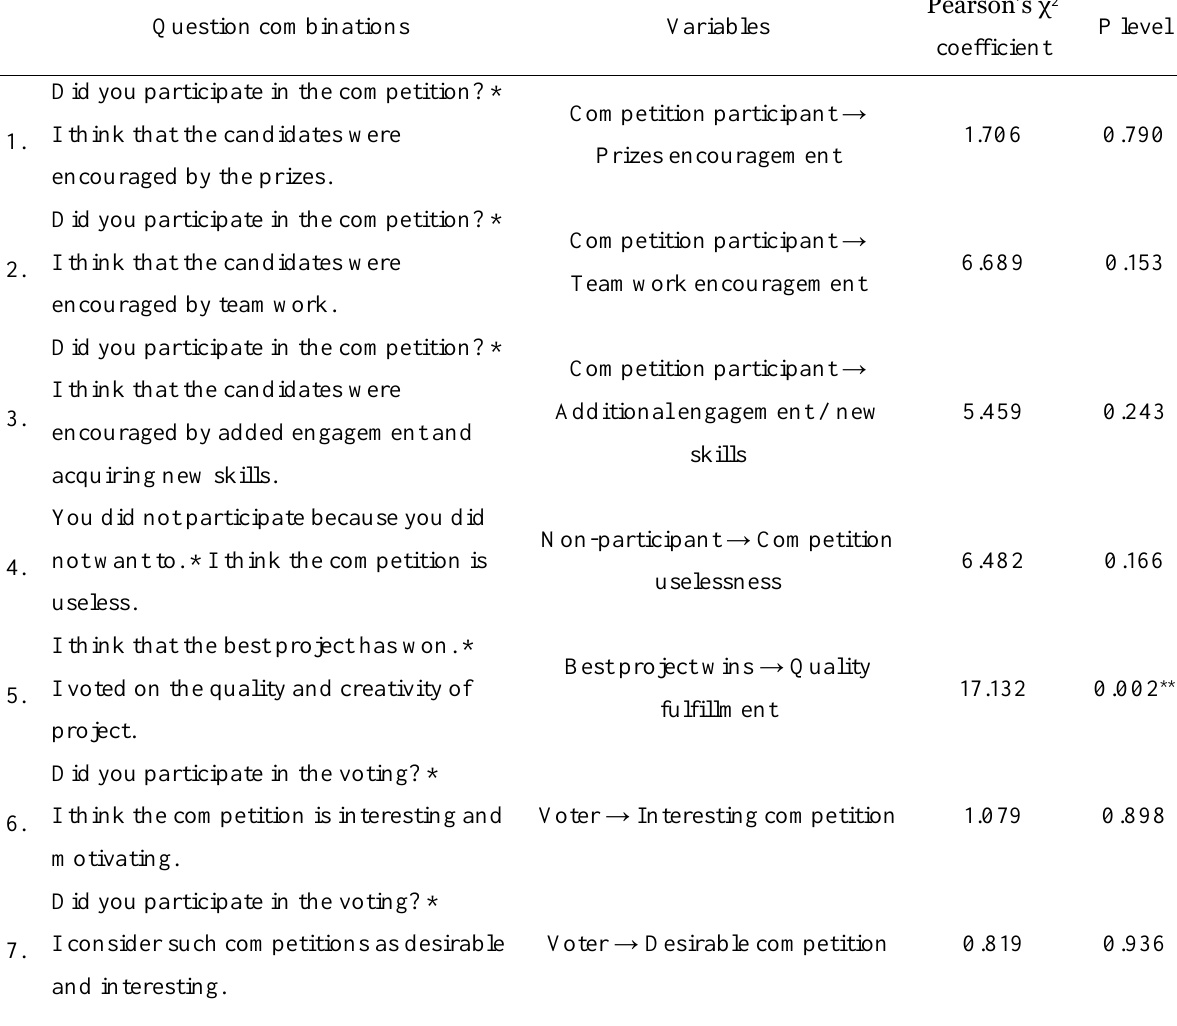
Results of the Pearson’s χ 2 Coefficient for Examined Variables Question combinations Variables